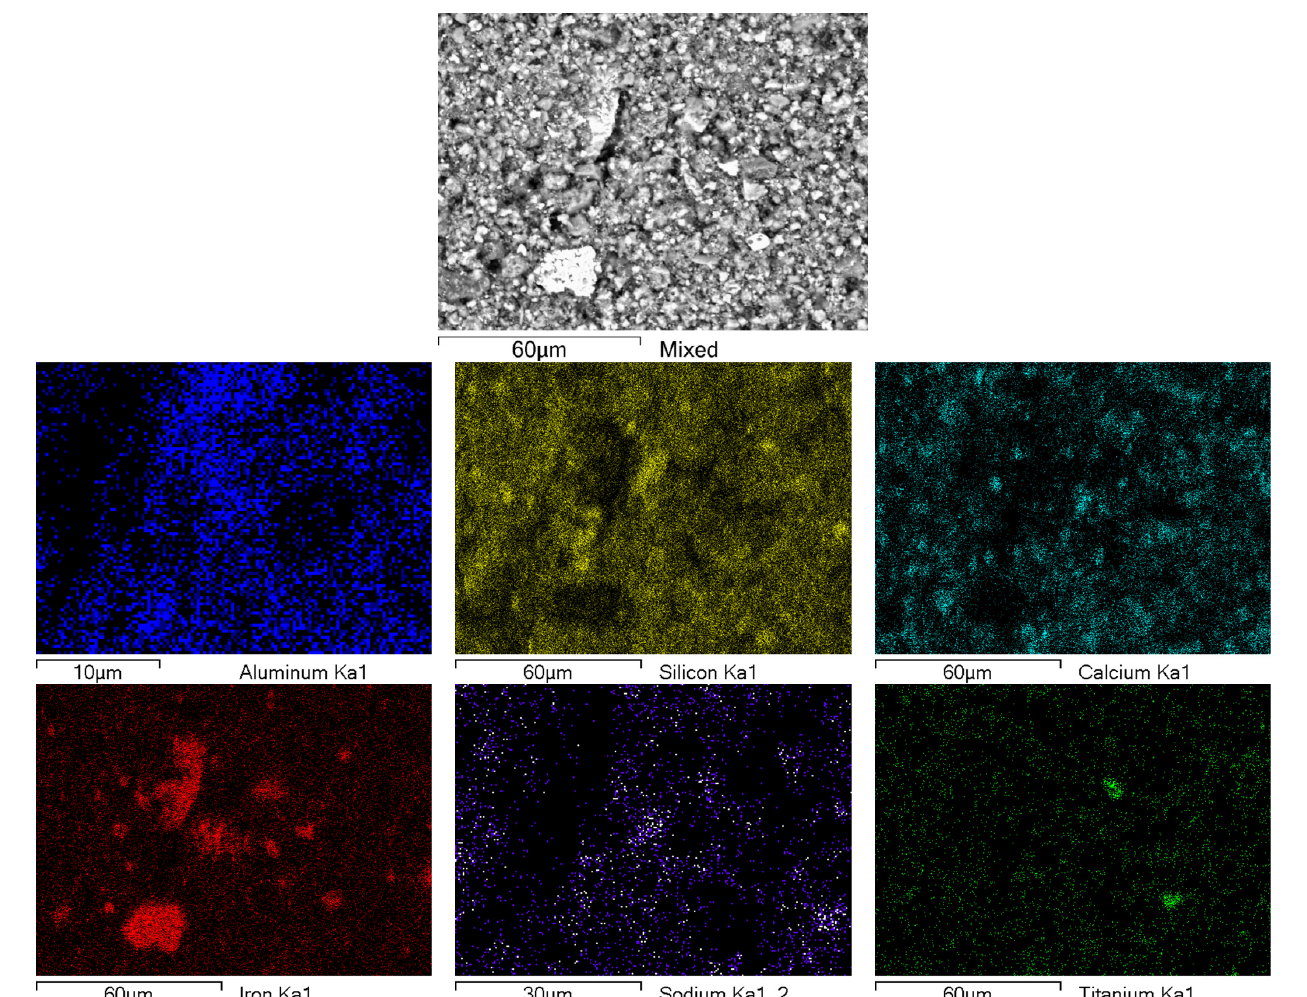
Figure 2. SEM–EDS analysis of the red-mud sample.